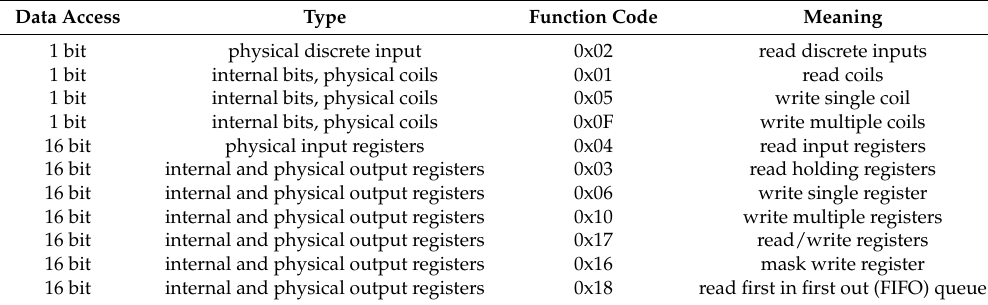
Table 1. Function codes for data access in